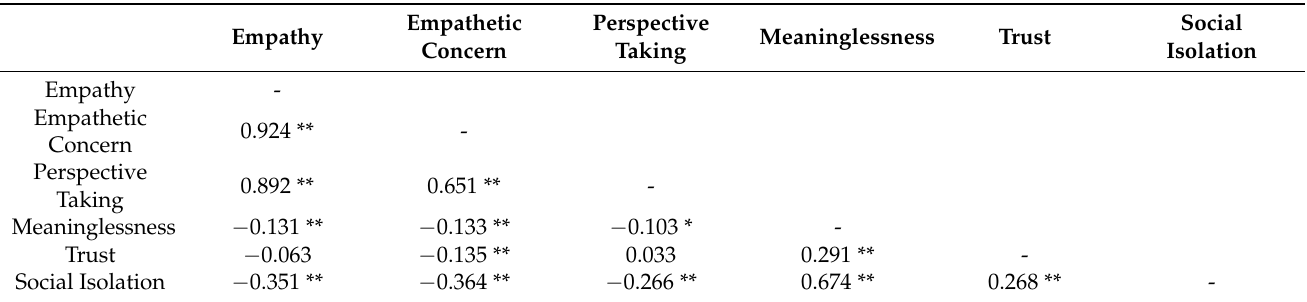
Table 4. Correlation Matrix for Empathy, Social Isolation, Meaningless and Trust.